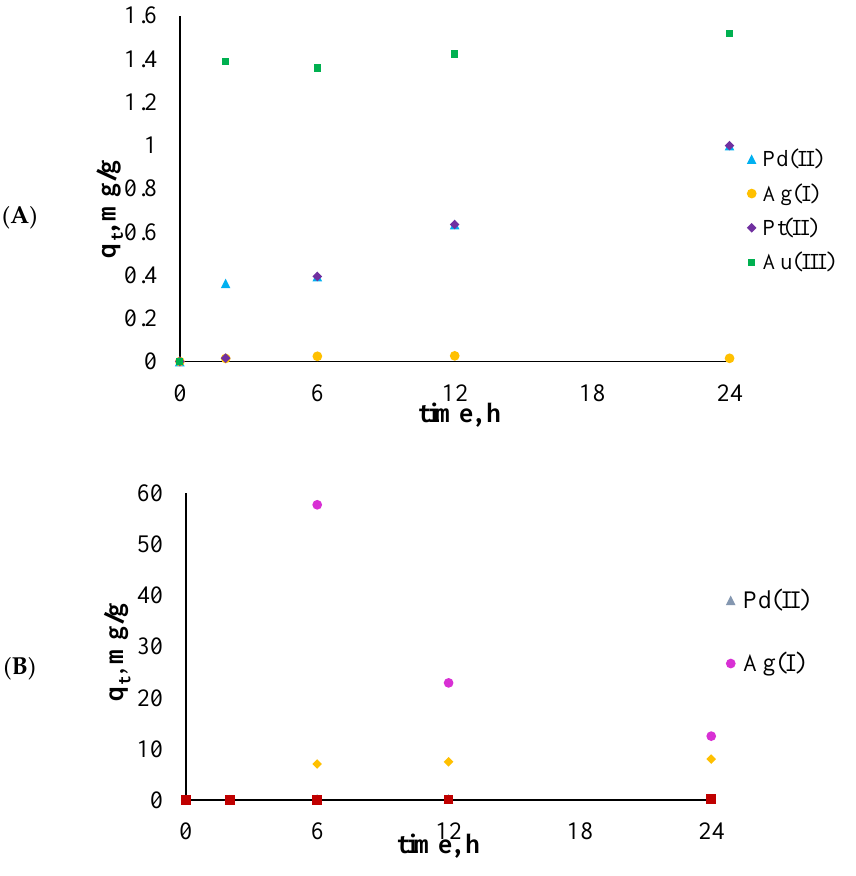
Figure 6. The changes in the sorption capacity of the polymer membranes with 20 wt.% salen as an ion carrier during sorption: ( A ) for single-component metal ions solutions, ( B ) for the polymetallic solution. The given values of q t carry ±0.02.